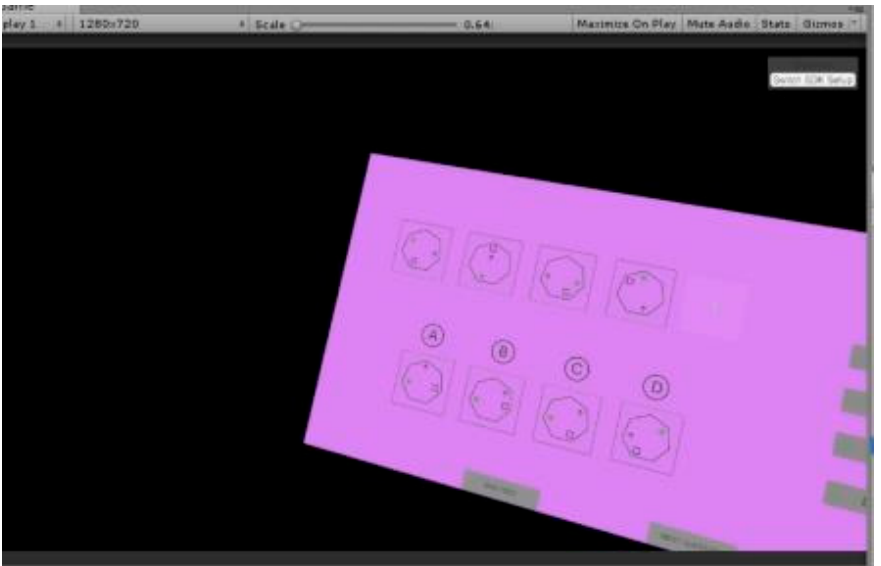
Figure A2. Examples of questions and 7 coloured backgrounds.